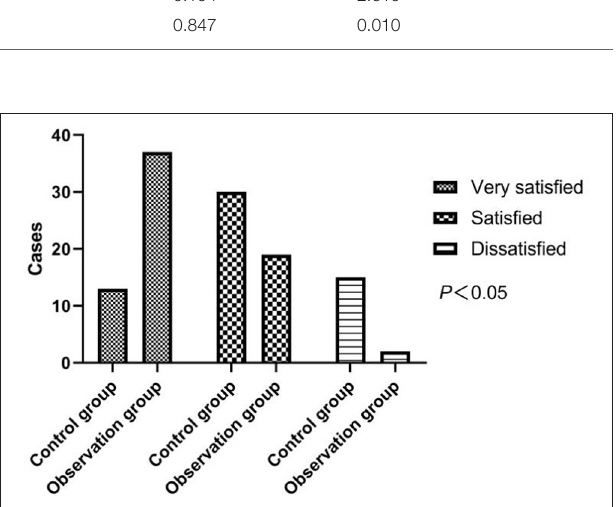
FIGURE 2 | Comparison of nursing satisfaction between two groups of